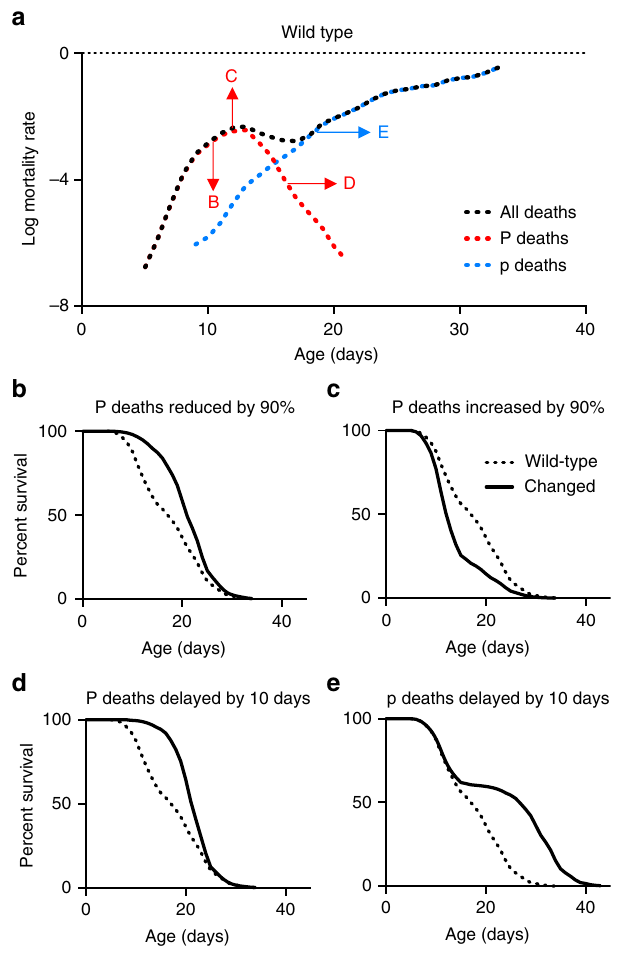
Figure 4 | How mortality deconvolution can decipher survival curves. ( a ) Log mortality rate of an idealized wild-type population. P and p survival were adapted from the P and p death survival calculations in Fig. 1g, and the survival proportions of the whole population were calculated, assuming that P death is 40% of the population and p death is 60%. The resulting survival data were used to calculate the log mortality rate. Arrows show the direction of mortality rate shift by transformations of survival data resulting in lifespan changes shown in ( b – e ). Dotted lines, wild-type data; solid lines, data after specified transformation. ( b ) 90% decrease in P deaths. ( c ) 90% increase in P deaths. ( d ) 10-day delay in P deaths. ( e ) No change in P deaths, with 10-day delay in p deaths. For mortality rate plots for ( b – e ), see Supplementary Fig.